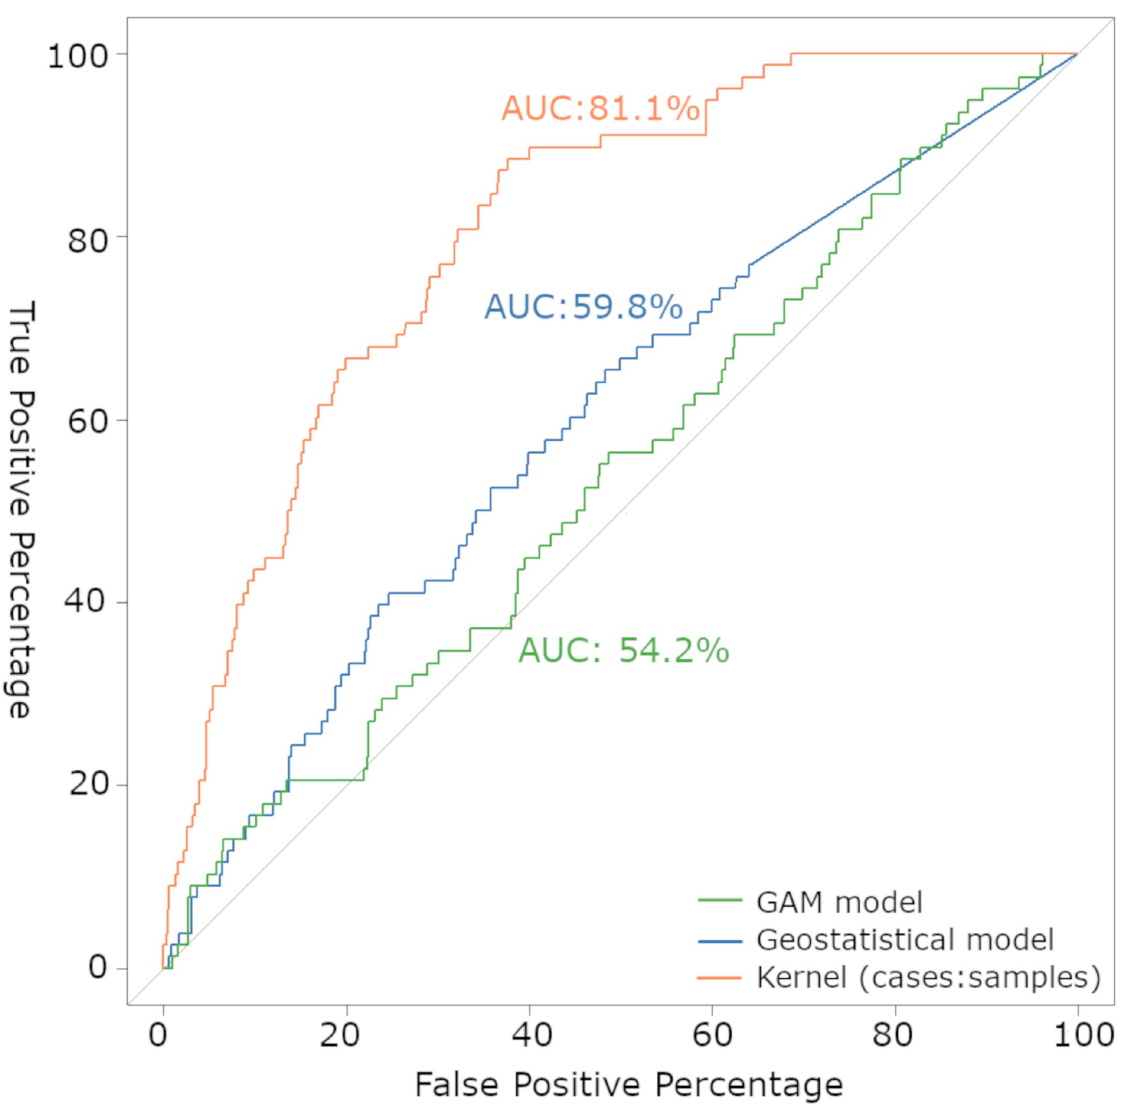
Fig 7. Area under the receiver operating characteristic (ROC) for canine visceral leishmaniasis models. For each model, the AUC was calculated with 95% confidence intervals. The best model in predicting canine risk disease was the Kernel density ratio